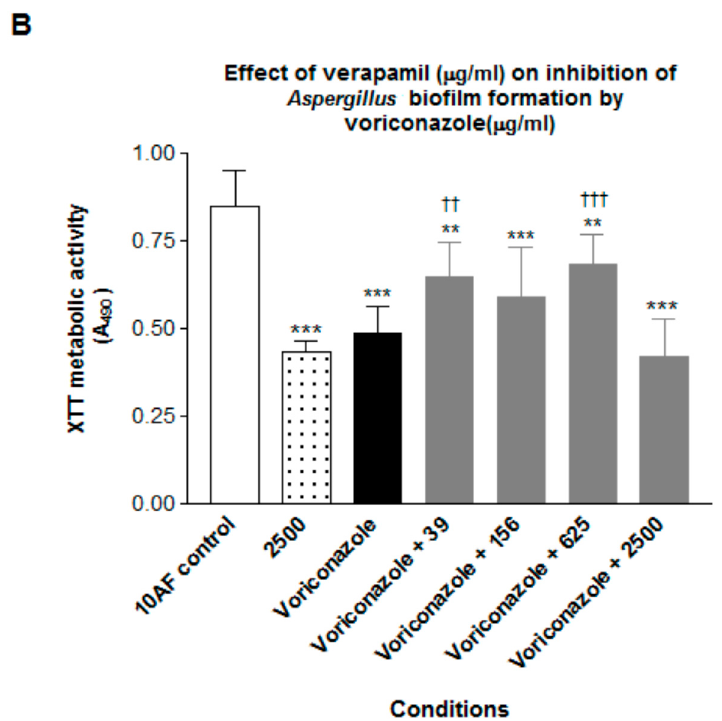
Figure 1. ( A ) Verapamil 39 mcg/mL alone was inhibitory, as shown here (sixth bar from left). This is a study of the effect of voriconazole doses on the effect of verapamil on formation of Aspergillus biofilm. The numbers 0.125 to 1 are final voriconazole concentrations in mcg/mL, alone (second through fifth bars from the left) or in combination with verapamil 39 mcg/mL (four right bars). ***, p < 0.001 lower than the no drug control, left bar. †† and ††† are p < 0.01 and 0.001, respectively, vs. verapamil alone. Verapamil + 0.125 voriconazole is not only less inhibitory than verapamil alone ( ††† ), but also than 0.125 voriconazole alone ( p < 0.001). Verapamil + 0.25 voriconazole is not only less inhibitory than verapamil alone, but also less inhibitory than 0.25 voriconazole alone ( p < 0.01). Verapamil + 1 mcg/mL voriconazole is not only less inhibitory than verapamil alone ( ††† ), but also less inhibitory than 1 mcg/mL voriconazole alone ( p < 0.05). ( B ) The effect of verapamil doses on the effect of voriconazole on formation of Aspergillus biofilm can be seen. The numbers 39 to 2500 represent the final concentration of verapamil, alone or in combination, in mcg/mL. The final voriconazole concentration, alone or in combination was 0.125 mcg/mL. ** and ***, p < 0.01 and 0.001, respectively, compared to no drug control (left bar). †† and ††† , p < 0.01 and 0.001, respectively, less inhibition in combinations compared to voriconazole alone. Antagonism is again demonstrated.